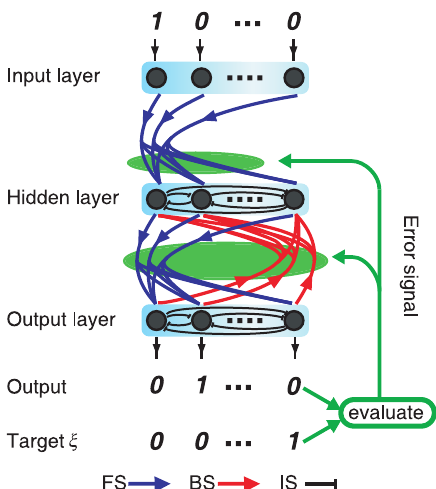
Figure 1. Schematic representation of the network architecture of our model. FS (BS) represents the interlayer forward (backward) excitatory synapse, and IS represents the mutually inhibitory intralayer synapse. Error signal represents the difference between an output and a target pattern and regulates the plasticity of all subsequent FSs and BSs (Eq.3) (green arrows and ellipses).